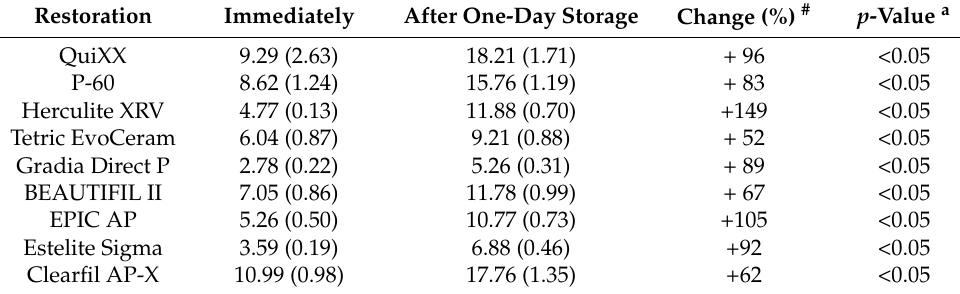
Table 6. Flexural modulus of restorative materials (GPa, mean